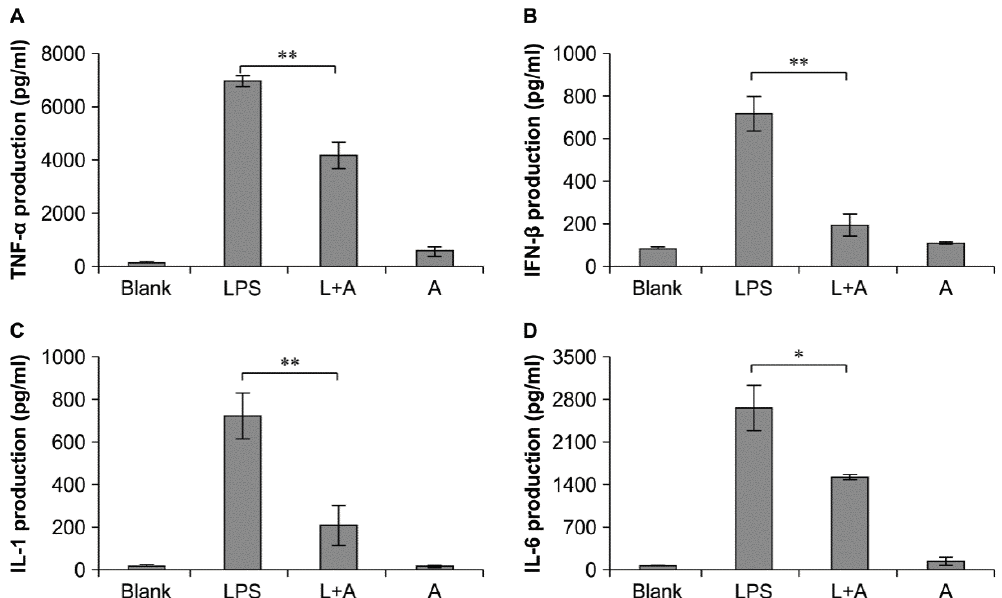
Figure 5. Inhibitory effect of humanized anti-TLR4 antibody Fab on cytokine expression in cell culture supernatant of LPS-stimulated mouse macrophages. ( A – D ) represent levels of TNF- α , IFN- β , IL-1, IL-6 in mouse macrophage culture supernatant determined by ELISA analysis. L: LPS; A: humanized anti-TLR4 antibody. Data are shown as mean ± SD ( n = 3, * p < 0.05, ** p < 0.01 compare to LPS group).